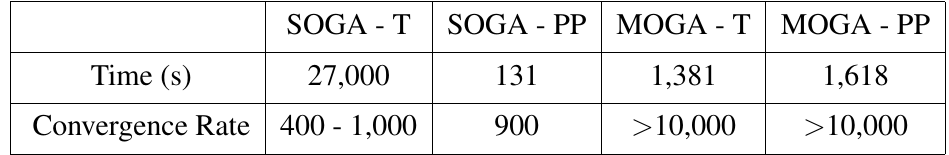
Table 9: Computational Efficiency for Physical